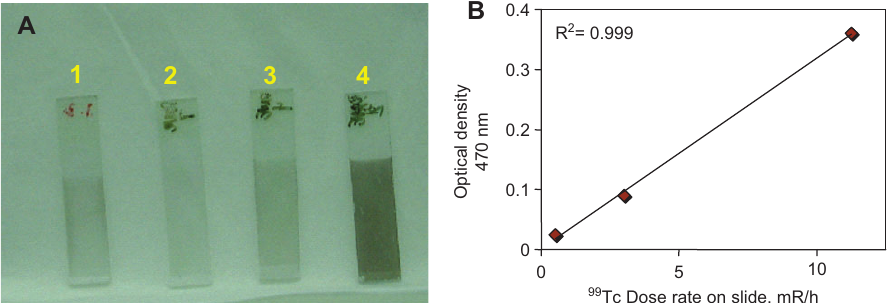
- on bare ITO electrode; 4